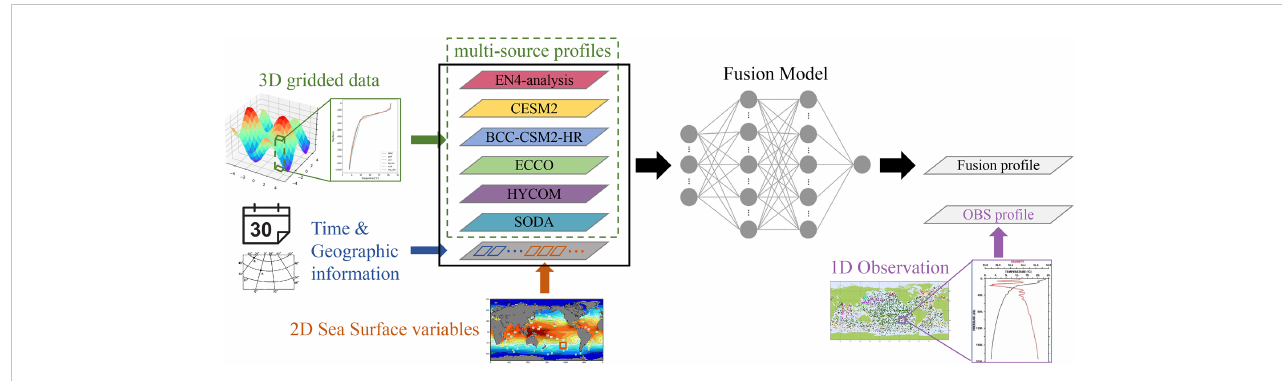
FIGURE 1 Framework for the intelligent fusion of multi-source heterogeneous ocean